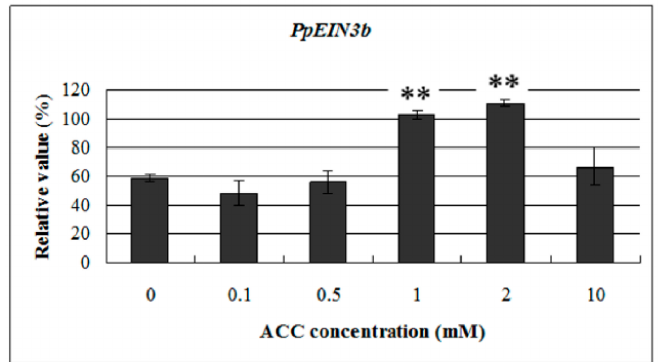
Figure 7. qRT-PCR analysis of PpEIN3b expression in fruit under ACC treatment. Relative values of PpEIN3b expression in fruit 145 days after full bloom treated for 12 h with 0.1, 0.5, 1.0, 2.0, and 10.0 mM ACC are shown as percentage of PpUBI expression. Mean values and standard errors (bar) are shown from three independent experiments. ** Very significant di ff erence between treated and control fruit ( p < 0.01) by t test. ACC: -aminocyclopropane-1-carboxylic